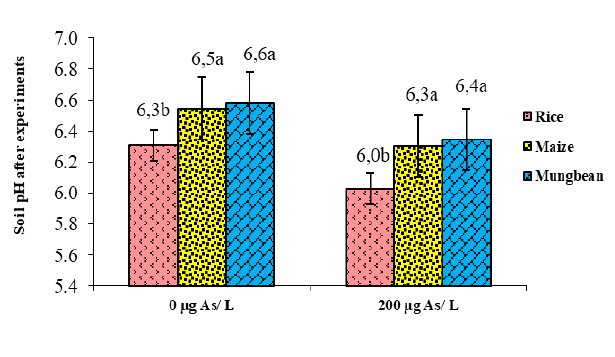
Fig.3. Effect of different irrigation waters on soil pH at the end of experiment